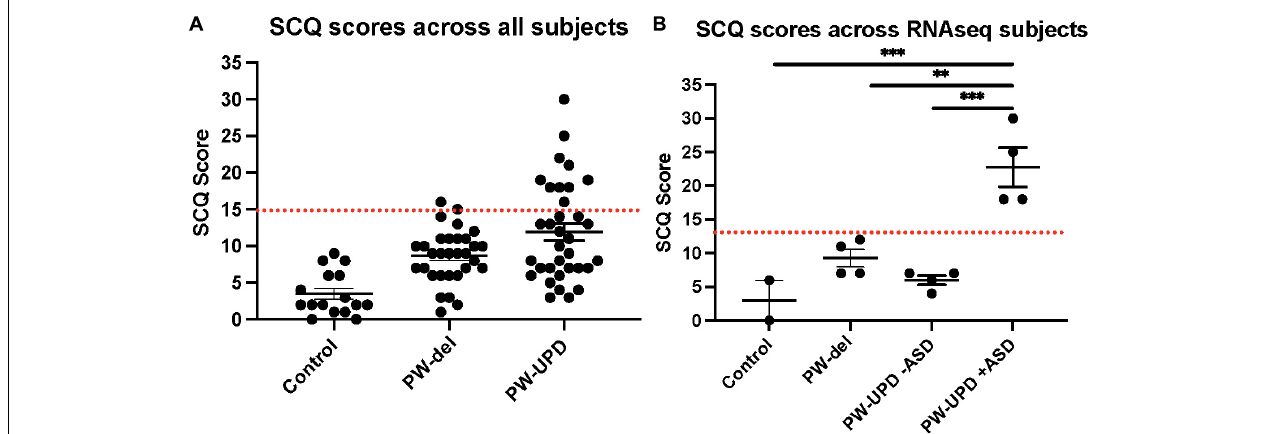
FIGURE 1 | Social Communication Questionnaire (SCQ) scores across all subjects. (A) SCQ scores across all subjects. (B) SCQ scores across individuals used for RNAseq analysis. A cutoff score of 15 (red line) is used as a threshold for “possible ASD.” The PW-UPD cohort has two segregated groups. Subjects that meet the criteria for “Possible ASD” (score of 15 or above) and those scoring within normal limits. For 2 of the neurotypical control subjects used, SCQs could not be collected. Significance testing was performed by one-way ANOVA testing. ** = p -value ≤ 0.01, *** = p -value ≤ 0.005.